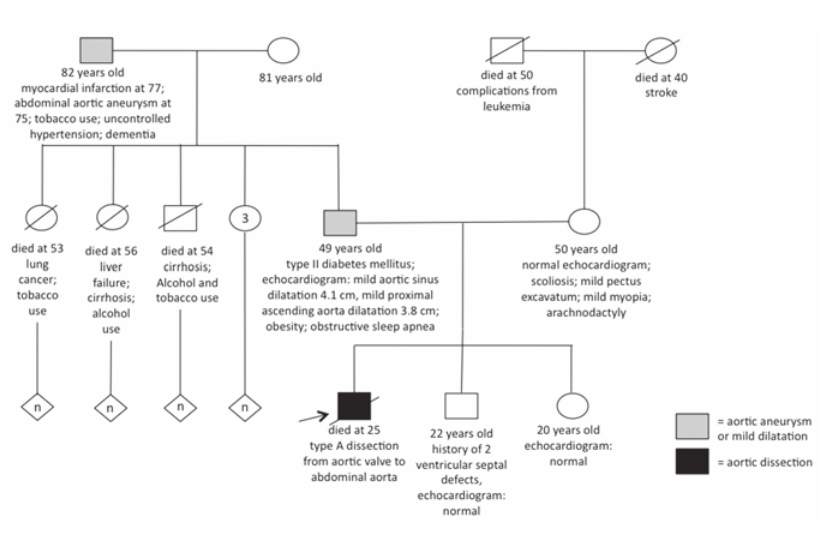
Figure 1. Three-generation pedigree with most recent cardiac